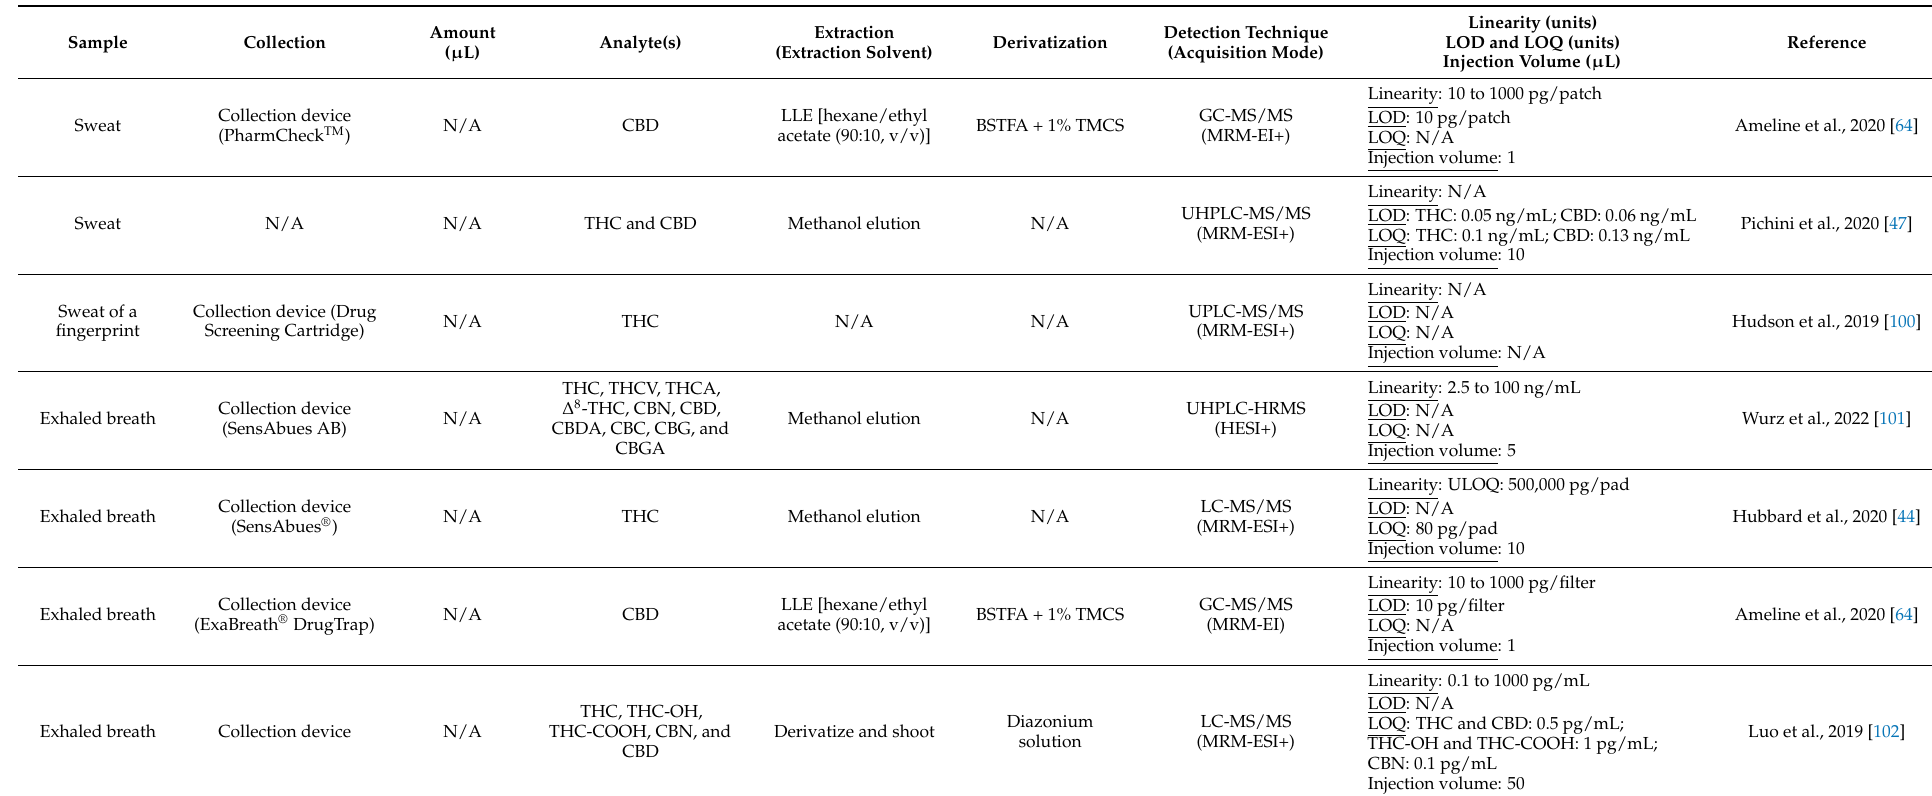
Table 6. Methods for the identification and quantification of cannabinoids in sweat and exhaled